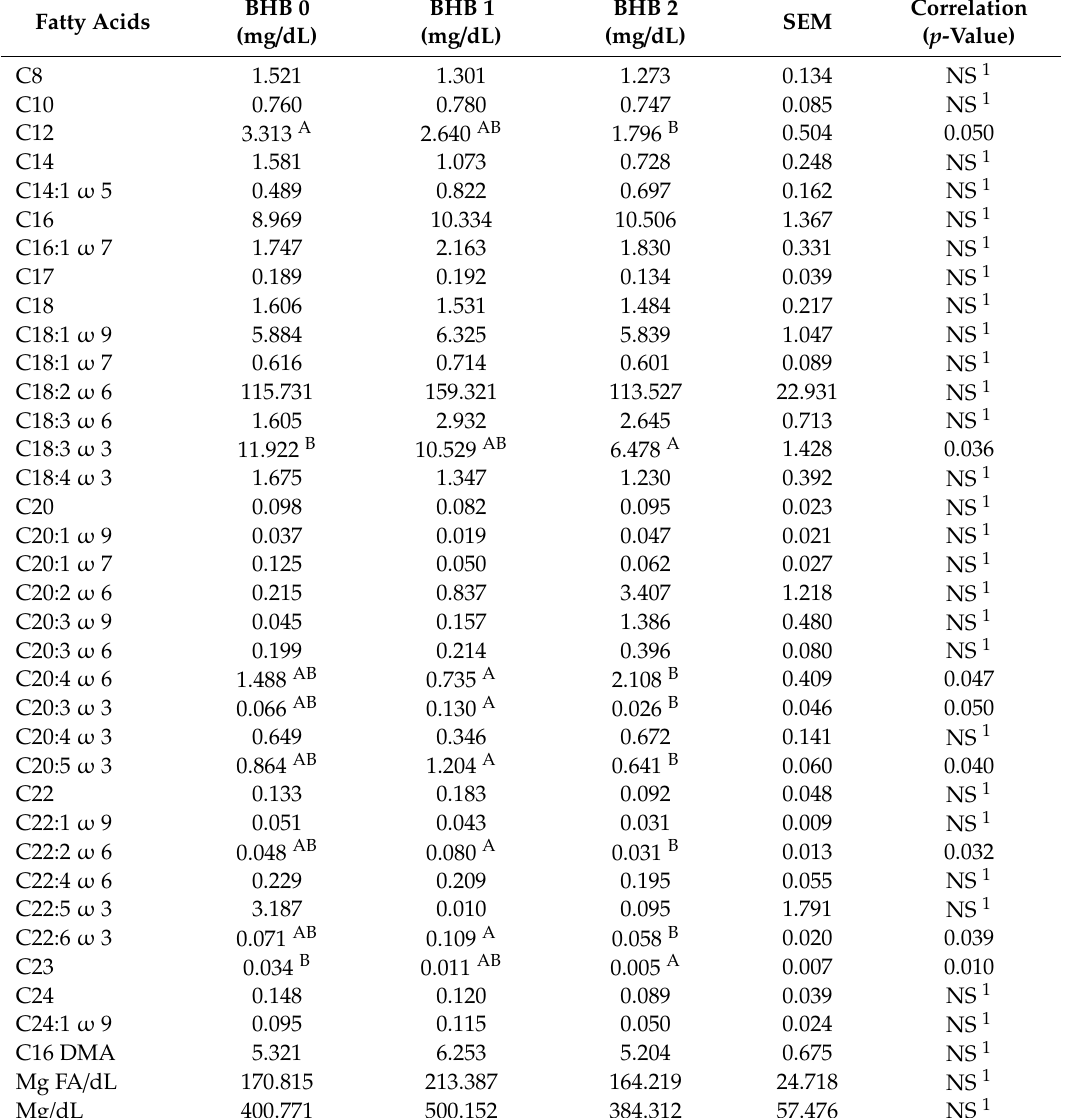
Table 6. Plasma fatty acid mean ( ± SEM) related to the lipid class of Cholesterol Esters (TLC-GC). Fatty